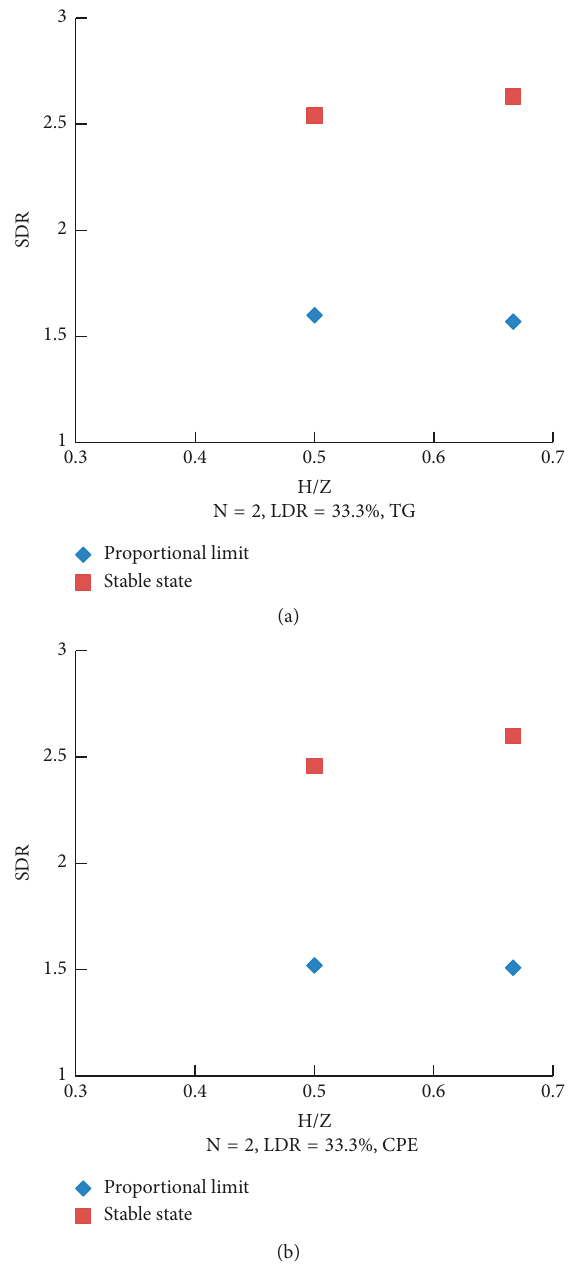
Figure 19: The relationship between SDR and H : (a) TG geobelt ( N 2; LDR 33.3%); (b) CPE geobelt ( N (cid:30) (cid:30)